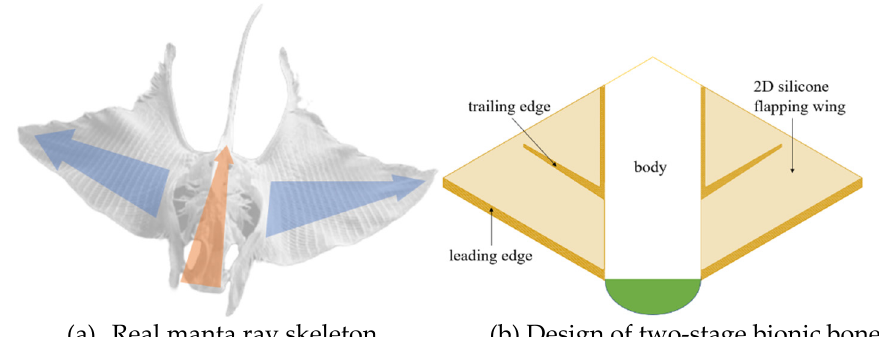
Figure 2. Bionic flapping wing design.